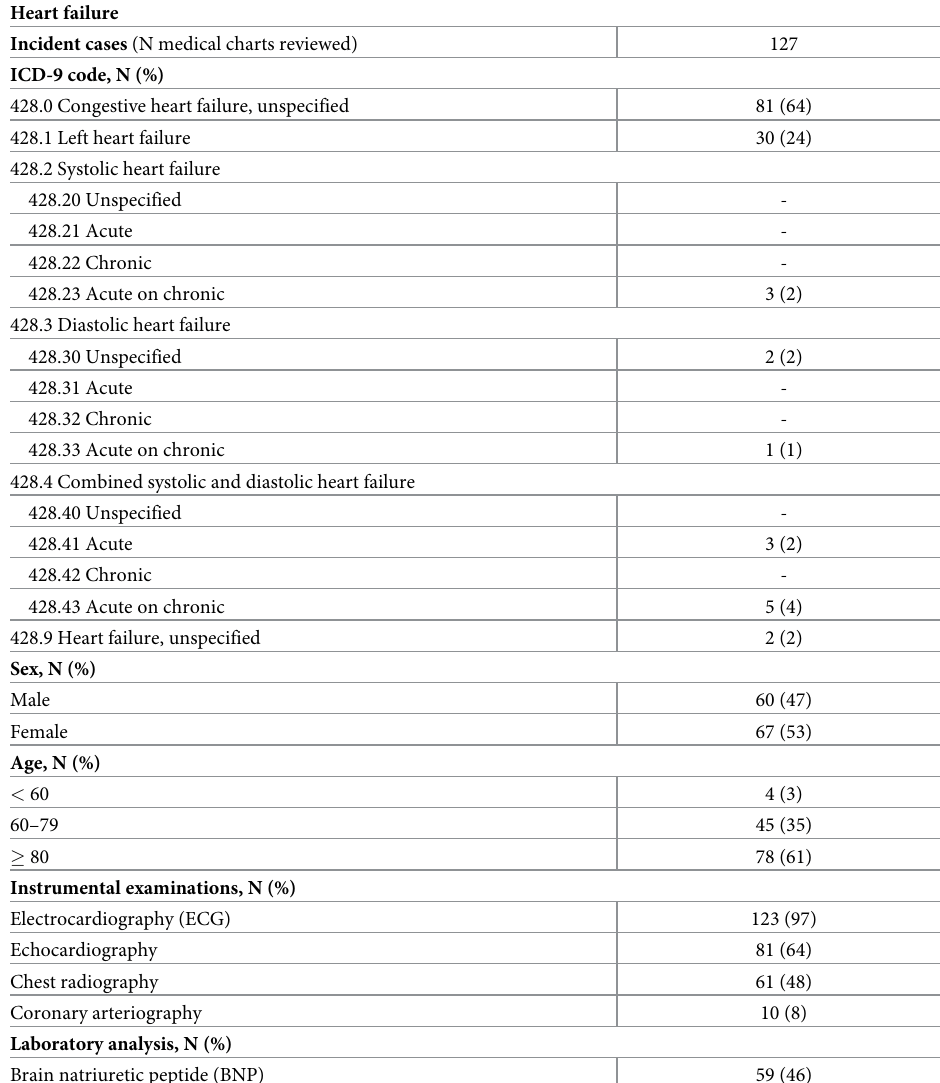
Table 3. Characteristics of patients with heart failure who were identified in the Regional Administrative Data- base of